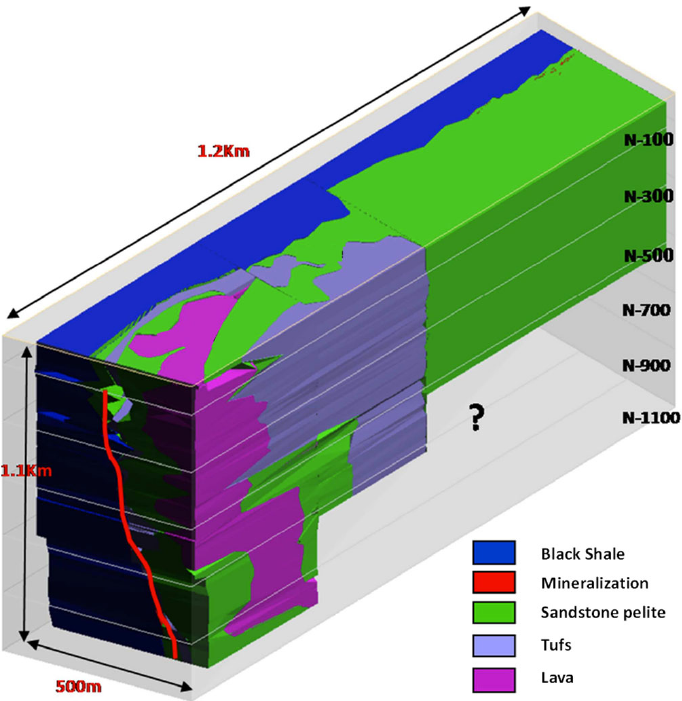
Figure 2. 3D geological block diagram of the Draa Sfar deposit [22].